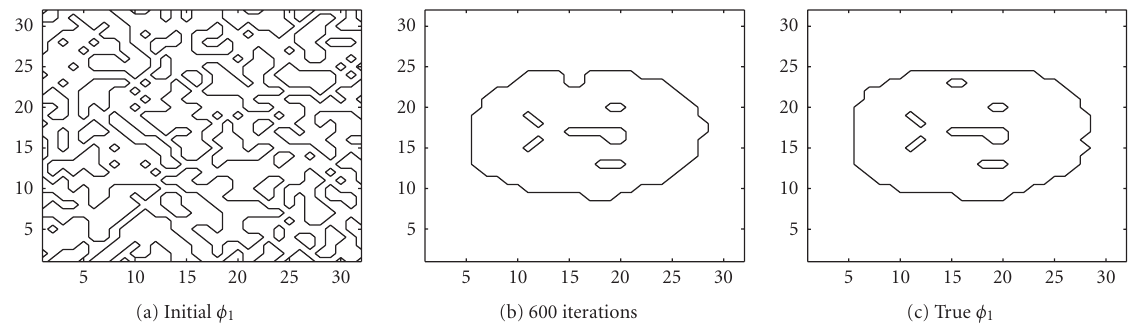
Figure 8: Interfaces given by the zero level set of the function φ 1 .